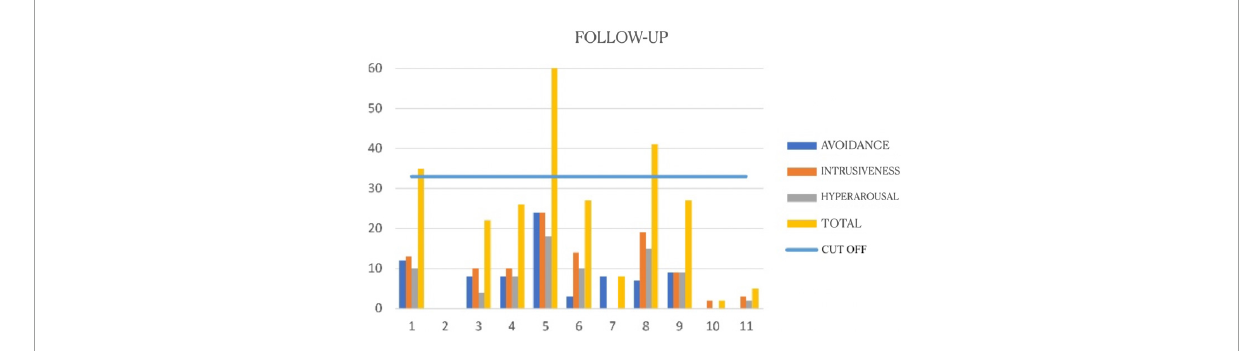
FIGURE3 Follow-up Impact of Event Scale-Revised (IES-R) (Weiss and Marmar,